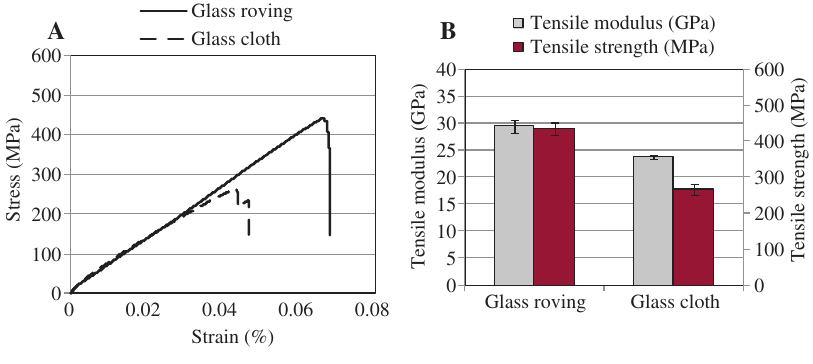
Figure 5 Tensile test results: (A) stress-strain curves and (B) modulus and strength graph.